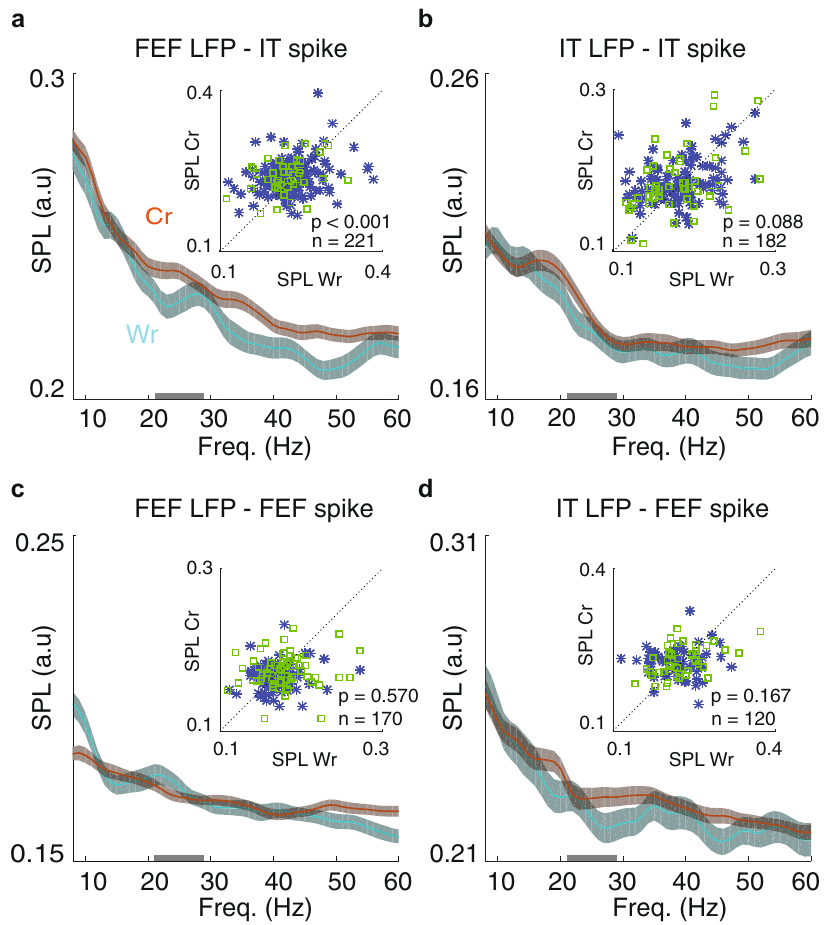
Fig. 4 IT spiking activity, coupled to FEF phase, re fl ected performance. a The beta band SPL between IT spikes and FEF LFPs re fl ected performance. Plots show the SPL for correct (brown) and wrong (cyan) trials across frequencies for all pairs of IT units and simultaneously recorded FEF LFPs. Gray bar on x -axis indicates the beta frequency range. Data were smoothed within a window of 1 Hz and represented as mean ± SEM. Inset scatter plots compare the beta band SPL for correct vs. wrong trials ( n = 221 pairs, p = 0.0009, Wilcoxon ’ s signed-rank test, two-sided). M1 plotted in blue and M2 in green. b – d , Plots show the SPL for correct and wrong trials across frequencies for all pairs of IT units and IT LFPs ( b , n = 182 pairs, p = 0.088, Wilcoxon ’ s signed- rank test, two-sided), FEF units and FEF LFPs ( c , n = 170 pairs, p = 0.570, Wilcoxon ’ s signed-rank test, two-sided), and for FEF units and IT LFPs ( d , n = 120 pairs, p = 0.167, Wilcoxon ’ s signed-rank test, two-sided). Smoothing and scatter plot as in a